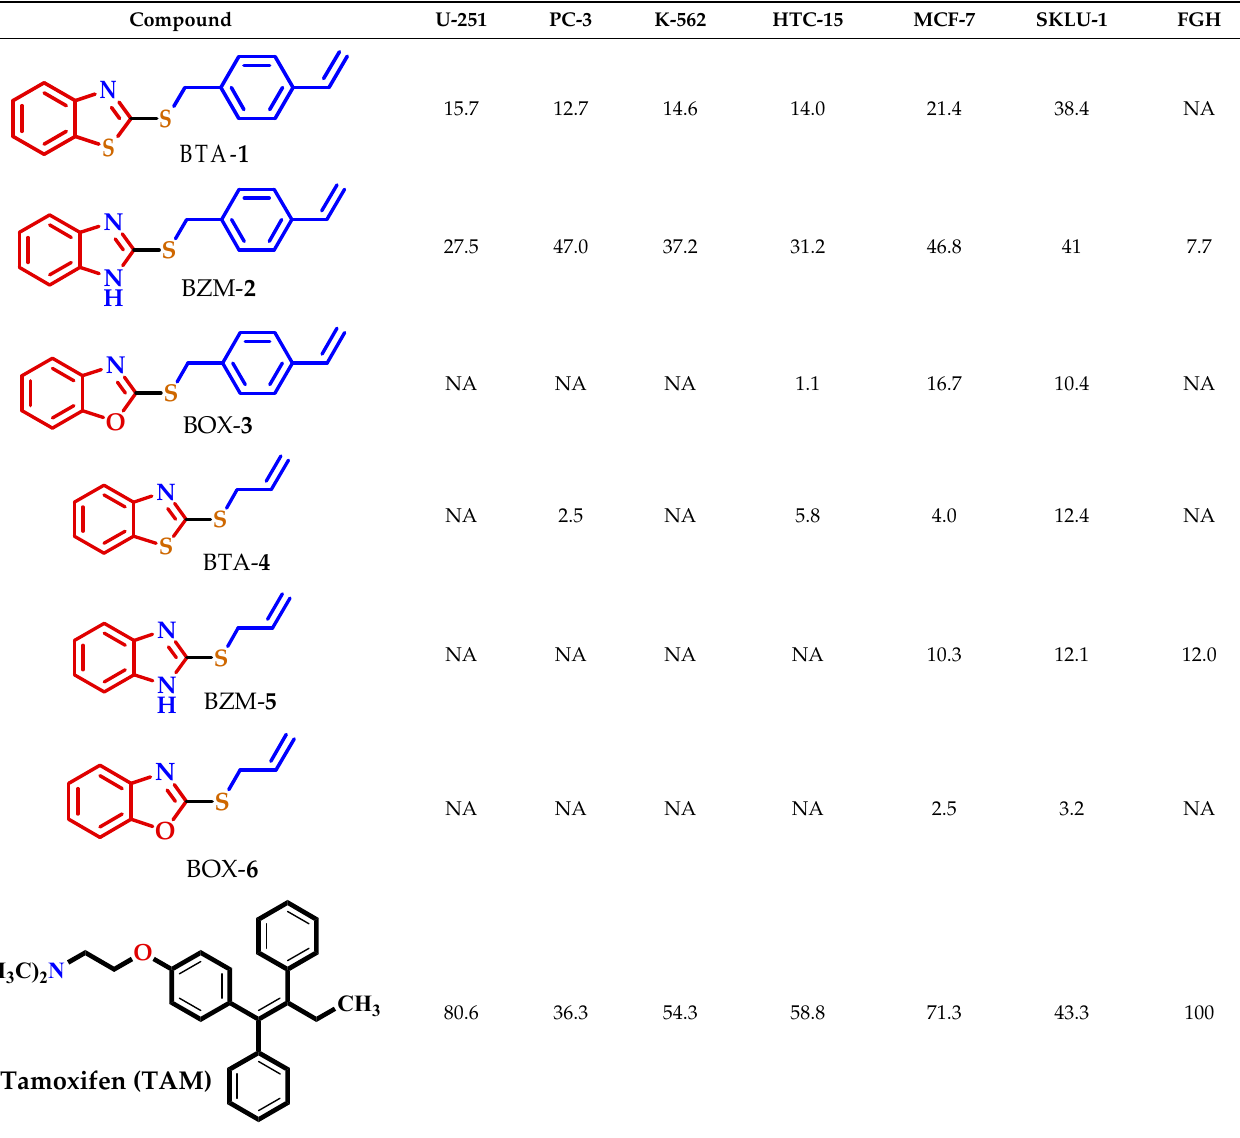
Table 3. % growth inhibitor of benzo [ d ] [1,3] azole derivatives ( BTA-1 , BZM-2 , BOX-3 , BTA-4 , BZM-5 , and BOX-6 ) against six human cancer cell lines (25 μM) *.